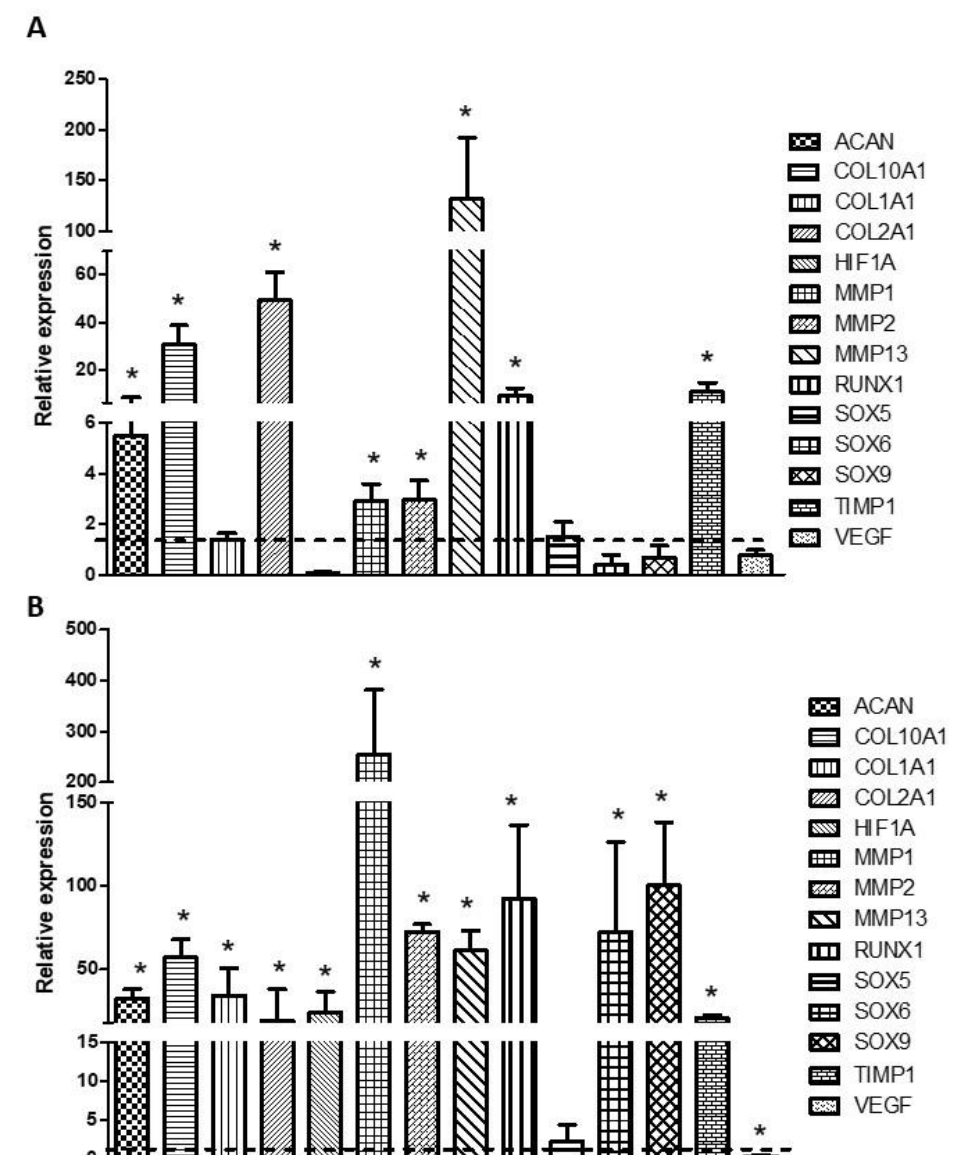
Figure 8. Levels of expression of chondrogenesis-related genes. Human primary chondrocytes ( A ) or hDPSCs ( B ) were encapsulated in 3% alginate-1% agarose hydrogels and cultured with proliferation or differentiation medium for 6 weeks at a density of 2 × 10 6 cells/mL. Relative levels of gene expression were evaluated by real-time RT-PCR. GAPDH was used as a housekeeping gene. The fold change (2- ∆∆ Ct) was calculated using the relative expression of cells cultured with proliferation medium as control group (indicated by the dotted line). Mean ± SD of three different experiments is represented. * p < 0.05 compared to control group.